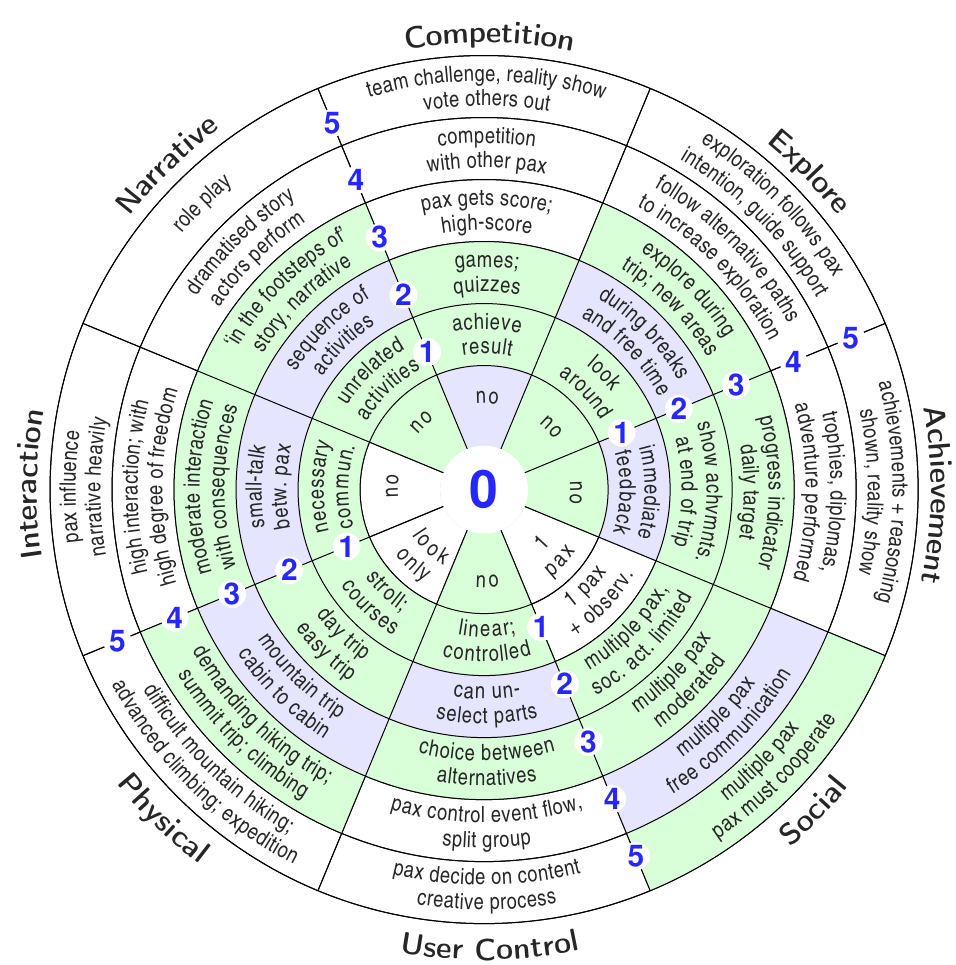
Figure 1. Trekking Engagement Profile with annotation of the fields. In addition, the characteristics of typical guided trekking tours are visualised with green colour; blue fields represent the values for a typical guided trekking tour from cabin to